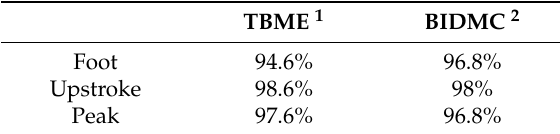
Table 3. PALMS PPG validation results (F1